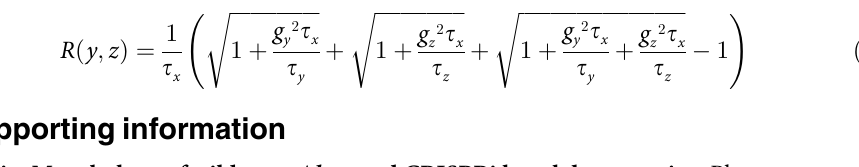
S1 Fig. Morphology of wild type, Δ lon , and CRISPRi knockdown strains. Phase contrast images of microcolonies after 200 minutes of growth. Slower growth rate and increased fila- mentation are evident in the Δ lon strain. S2 Fig. Half-life quantification for MarA in CRISPRi knockdown system and MarA fusion protein. Minute markers represent when sample was taken after spectinomycin